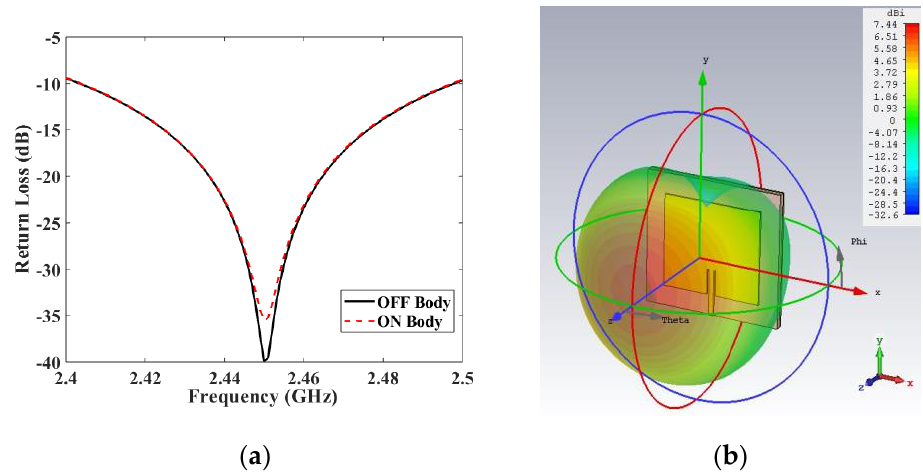
Figure 5. ( a ) S 11 simulated in both o ff and on body and ( b ) antenna directivity (dBi) in spherical 3D coordinates.